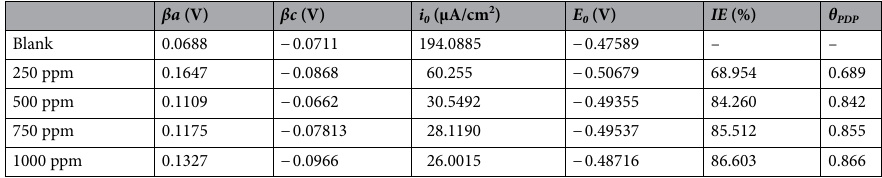
Table 3. PDP parameter obtained from extrapolation of Tafel curves for MS plates immersed in 1 M HCl solution with various concentrations of DPH after 24